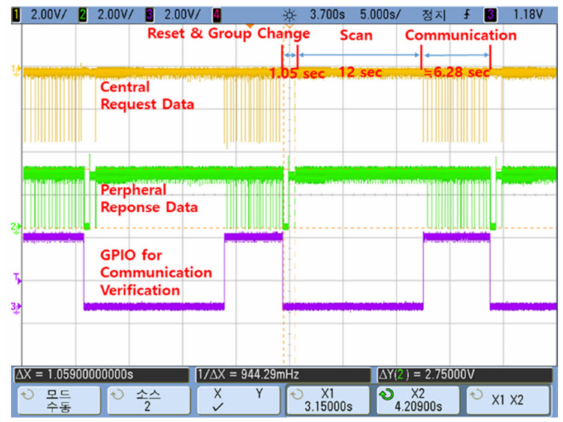
Figure 12. Result of group change for central processor.